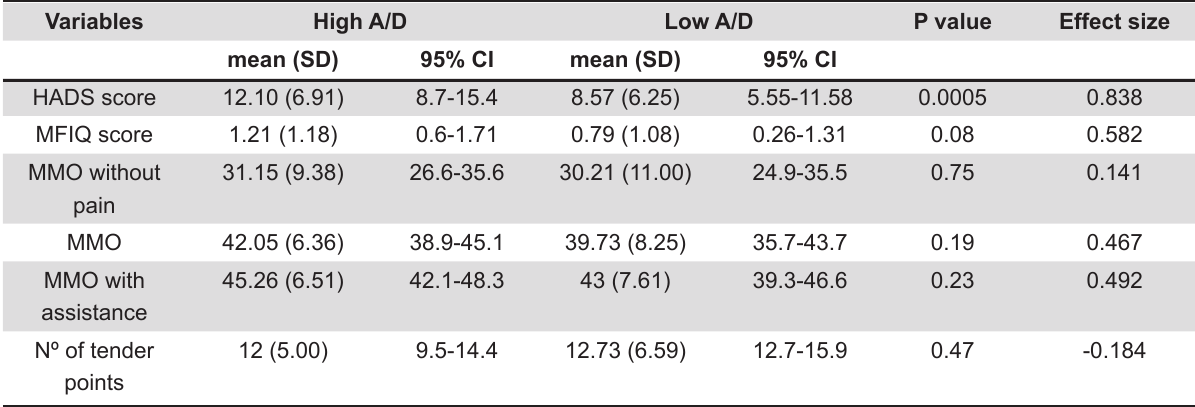
Table 1- Mean, standard deviation (SD), 95% confidence interval (CI), p-value and effect size of HADS and MFIQ scores, MMO in millimeters and number of tender points (n=19)